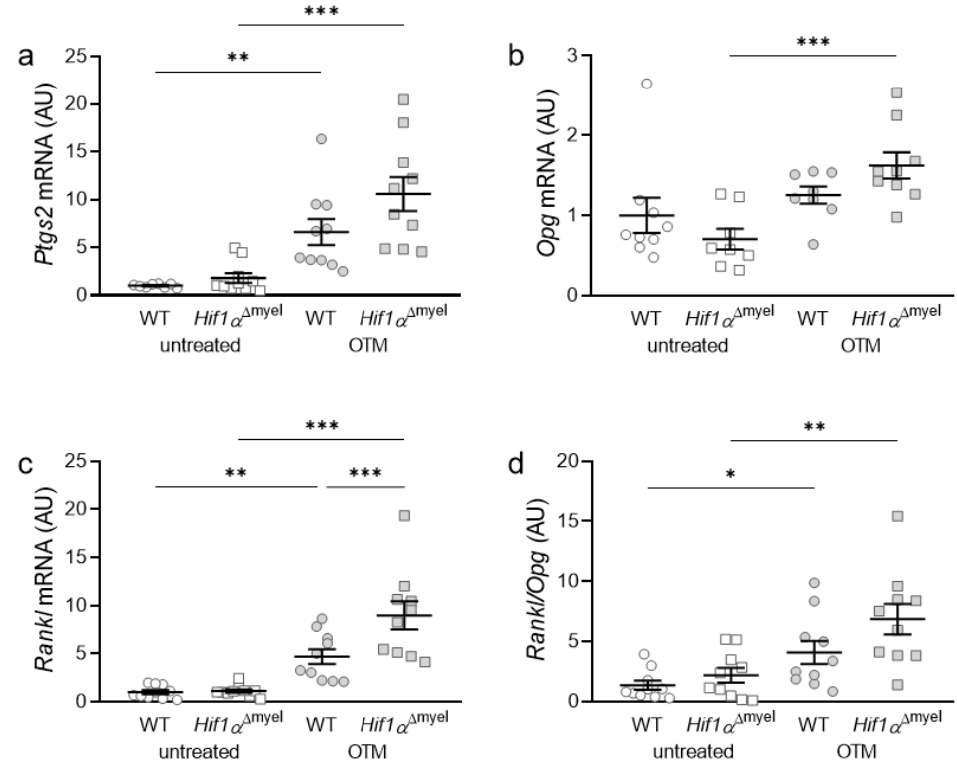
Figure 2. Gene expression of Ptgs2 ( a ), Opg ( b ) and Rankl ( c ) as well as the Rankl/Opg ratio ( d ) at the orthodontically treated (OTM) and the untreated control jaw side in wildtype mice (WT) and mice without HIF1 α in myeloid cells ( Hif1 α ∆ myel ). Statistics: ANOVA with uncorrected Fisher’s LSD post-hoc tests ( Rankl ) or Welch-corrected ANOVA with unpaired t tests ( Ptgs2, Opg, Rankl/Opg ). n ≥ 8; * p < 0.05; ** p < 0.01; *** p < 0.001.